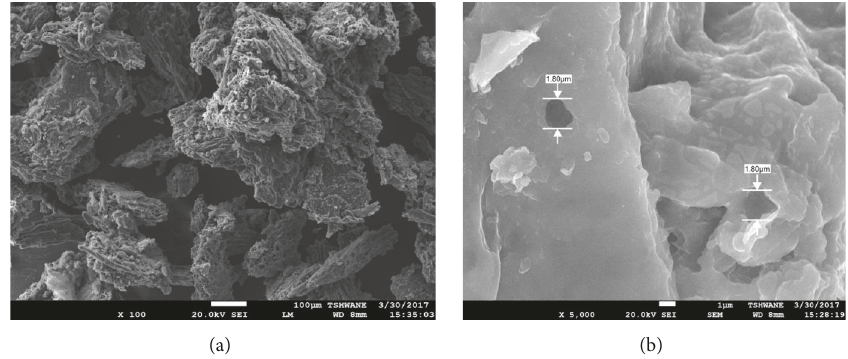
Figure 11: (a) Overview of 𝐴 3∗ from SEM analysis; (b) pore size distribution of 𝐴 3∗ at × 5000 magnification.